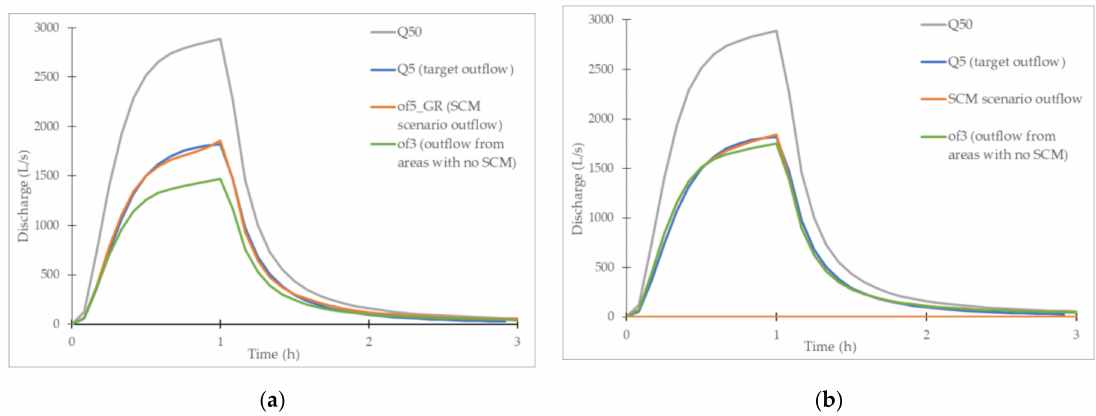
Figure 9. The results of the 3GR scenario, which includes three types of green roofs, for DE_Q5_P50: ( a ) 3GR area 90,000 m 2 , and ( b ) 3GR area 72,000 m 2